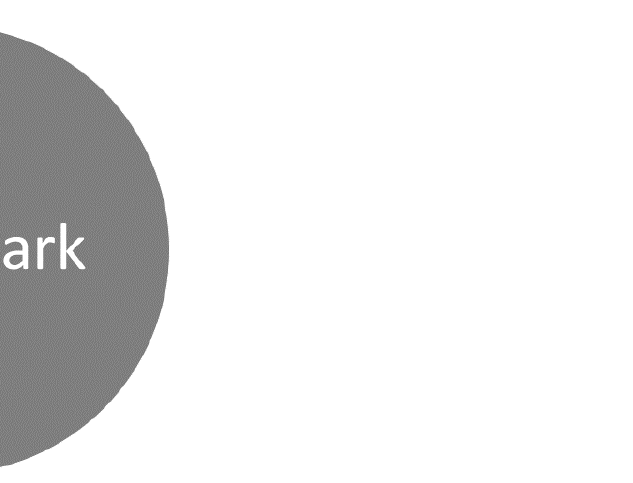
Figure 1. The DS of symmergence has two distinct sectors: The black particles which have only gravitational couplings to the SM, and dark particles that have gravitational couplings as well as the portal couplings in (44). The current collider and direct search bounds do actually agree with a black sector.